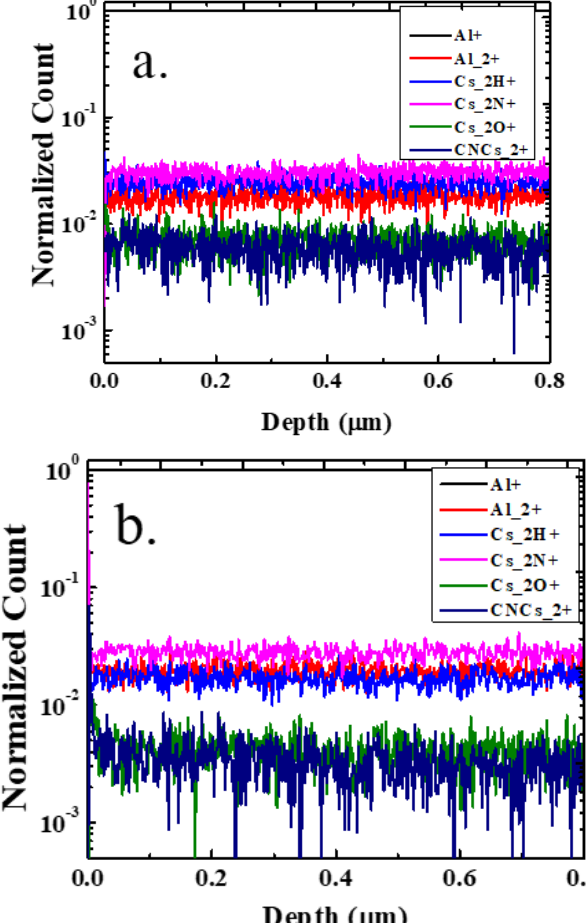
Figure 6. Depth profile for AlN SIMS spectra for different ions for AlN grown with ( a ) N 2 carrier gas, ( b ) H 2 carrier gas sample.